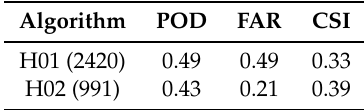
Table 7. Multi-category scores for Vale do Paraíba for H01 and H02. The number inside parenthesis concerns the number of matched pixel pairs for each algorithm.